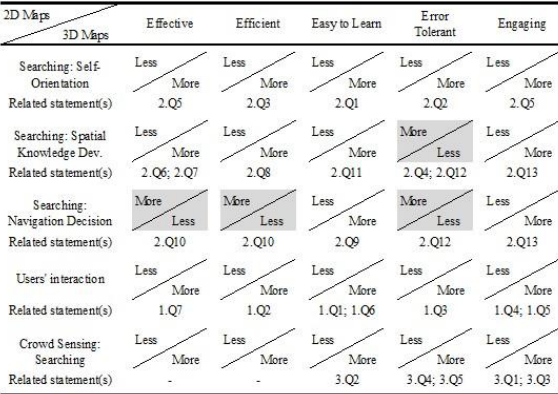
Table 7. Usability attributes of 3D map for pedestrian